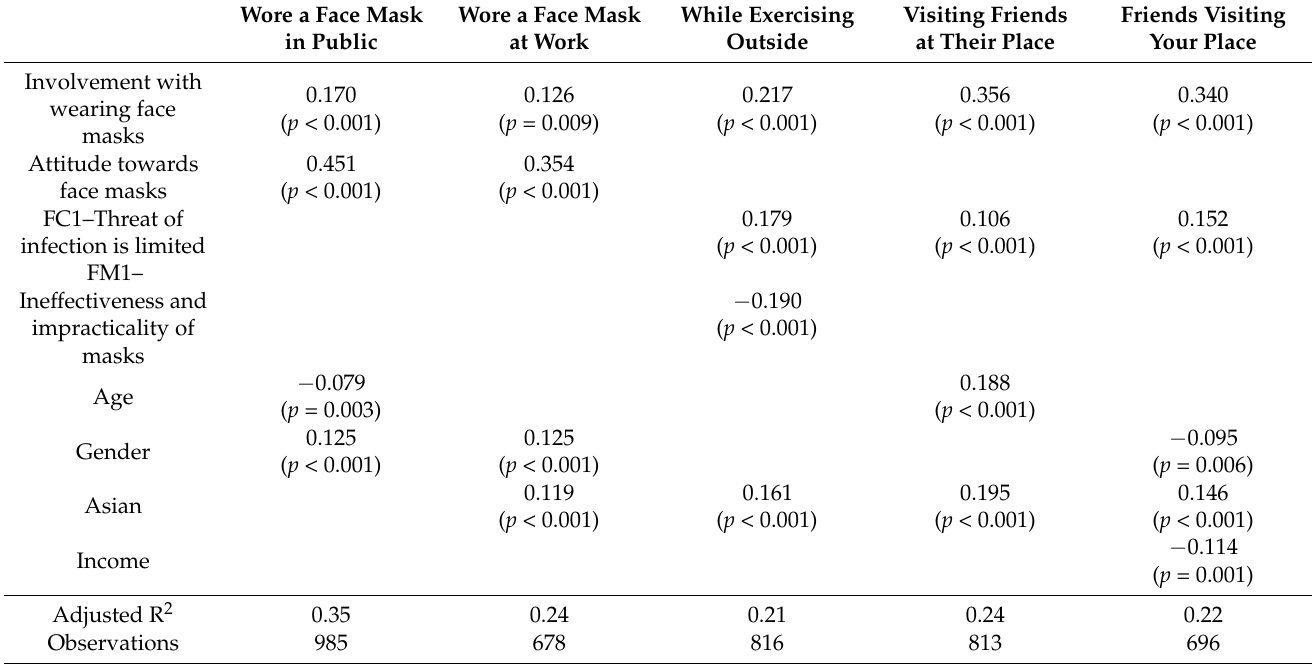
Table 8. Standardised parameter estimates for wearing face